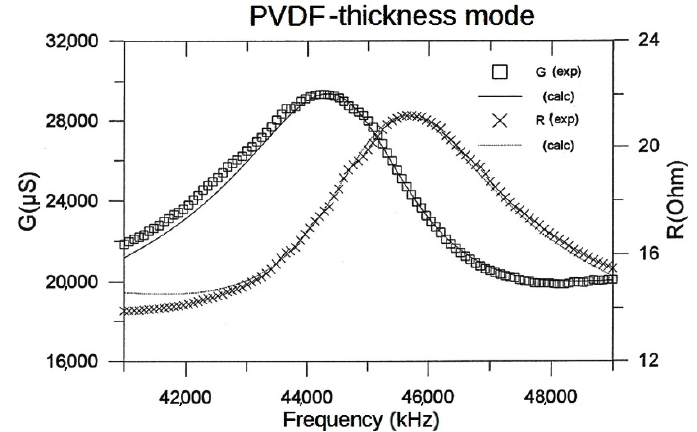
Figure 2. Example of the characterization of a piezoelectric polymer (PVDF: polyvinylidene fluoride).